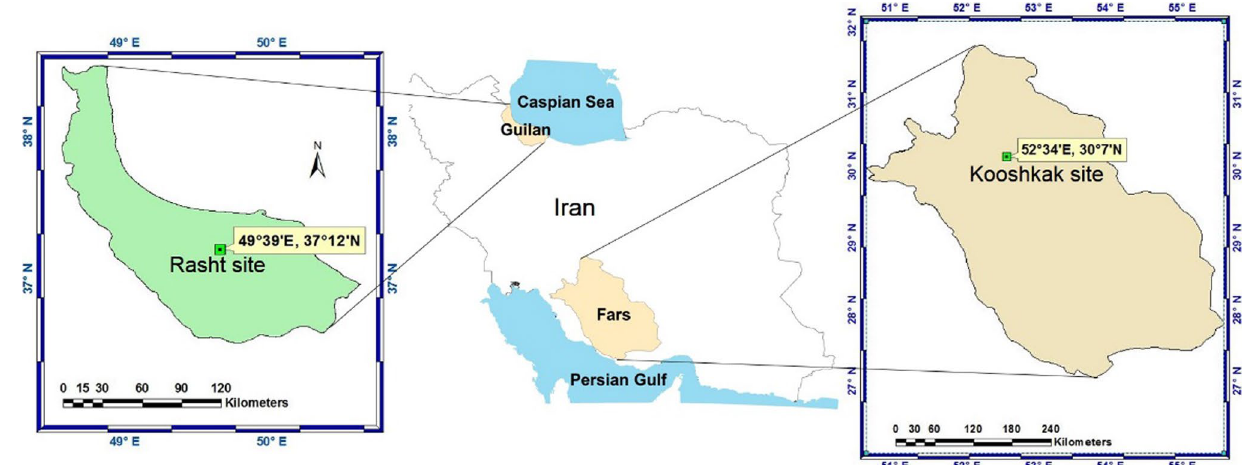
Fig. 1 Geographical positions of the experimental